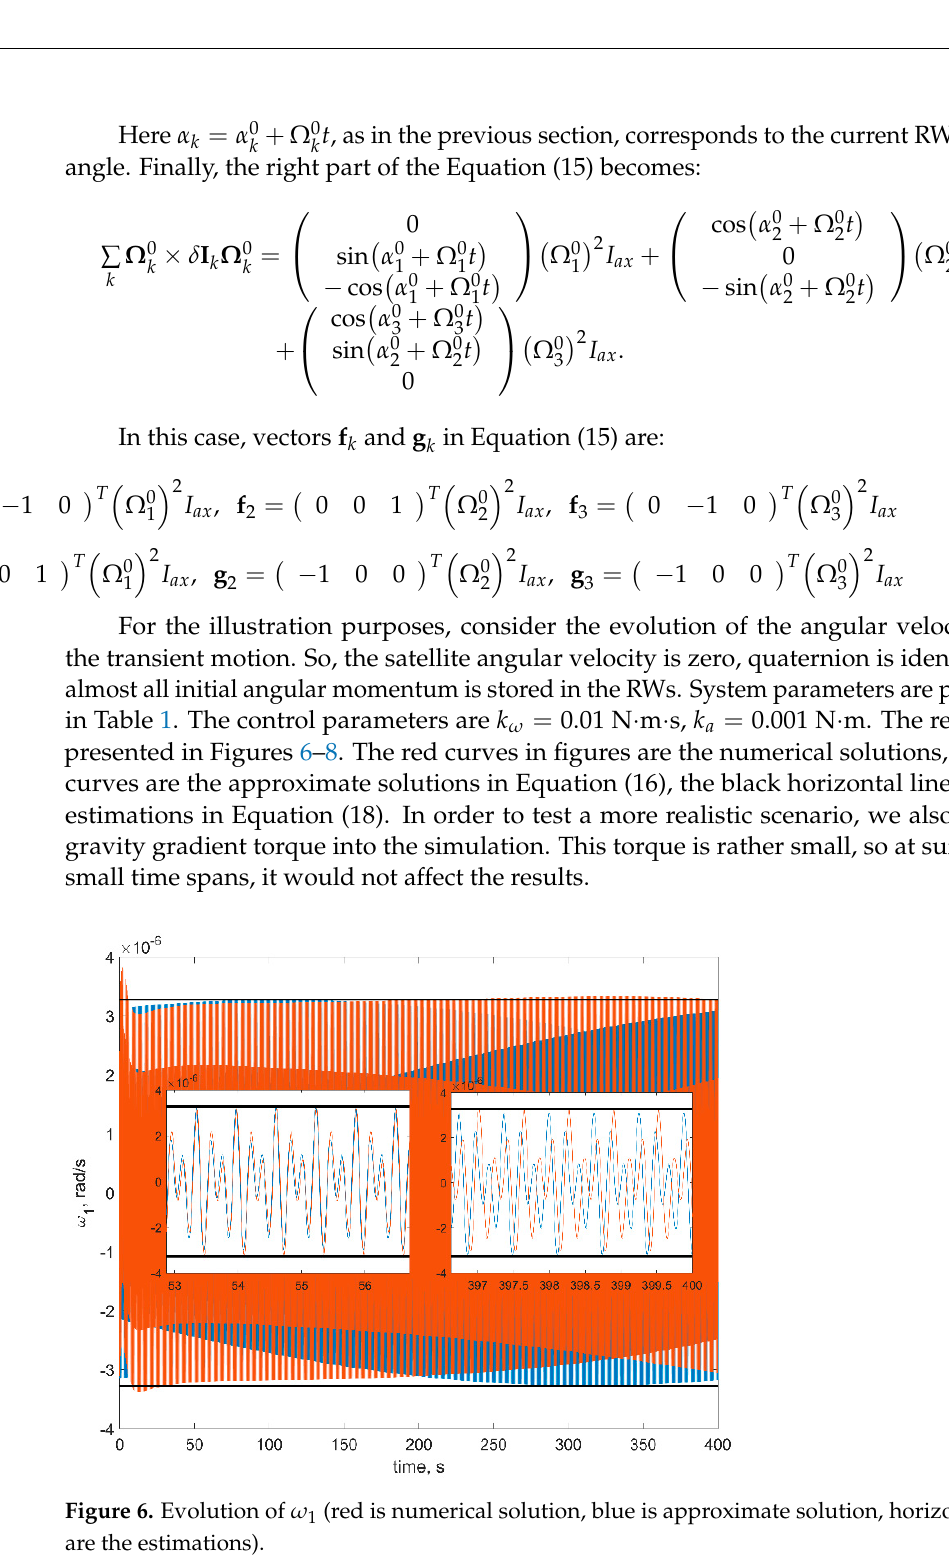
Figure 7. Evolution of 2 ω (red is numerical solution, blue is approximate solution, horizontal lines are the estimations).